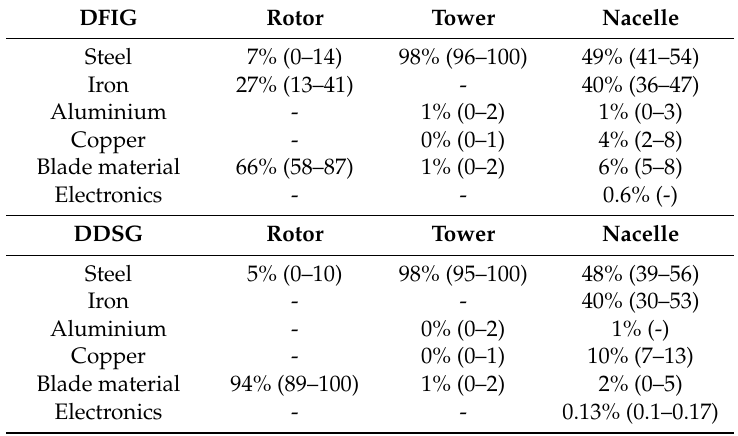
Table C1. Material specification per turbine part shown as mean percentage [44–49]. Smallest to largest percentages found are shown in parenthesis. DFIG